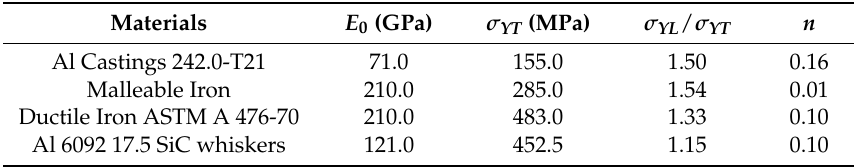
Table 3. Four engineering materials and their anisotropic parameters [25,44].